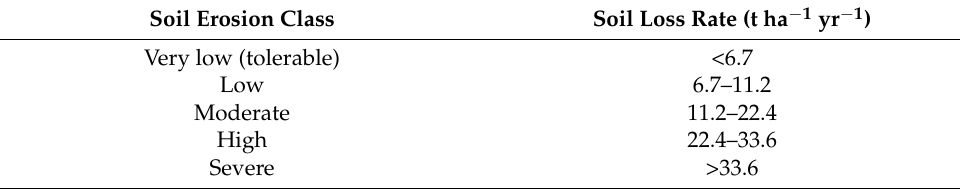
Table 4. Soil erosion classes and the corresponding soil loss